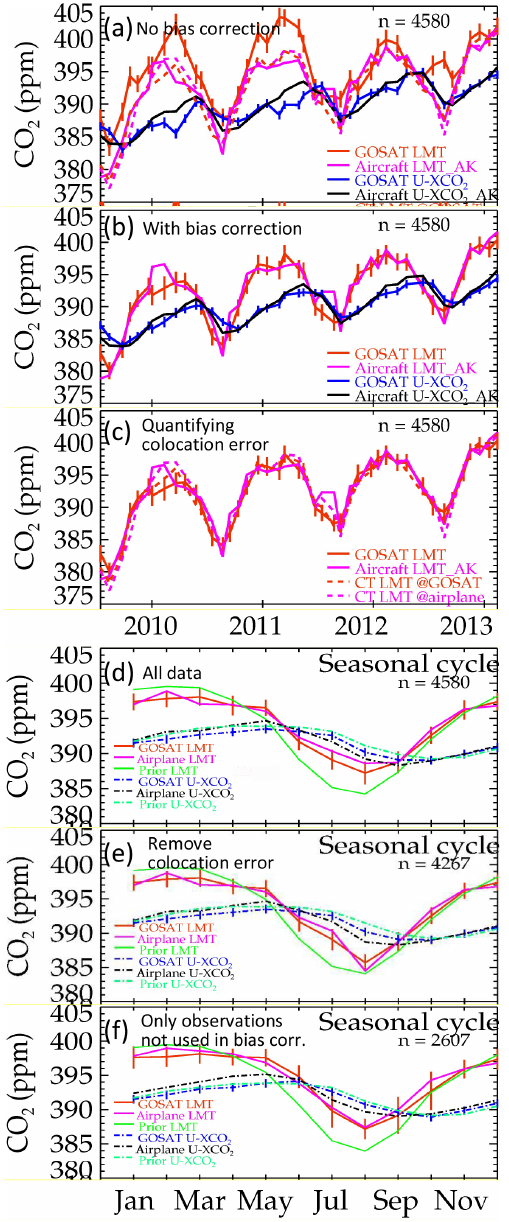
Figure 5. GOSAT versus aircraft data at the SGP site (37 ◦ N, 95 ◦ W). (a, b, c) Aircraft LMT (pink) and U (blue) versus GOSAT LMT (red) and U (black) for monthly averages of GOSAT and air- plane matches. (a) Using no bias correction, (b) using bias cor- rection factors derived in Appendix A. (c) Also showing Car- bonTracker matched to GOSAT (red dotted) and CarbonTracker matched to aircraft (pink dotted) for LMT. (d) Seasonal cycle of GOSAT and airplane, same colors as top panels, and adding the priors in green. (e) Seasonal cycle, but removing months where the CarbonTracker differences seen in (b) are larger than 2.5ppm. (f) Same as (e) but with observations used in the bias correction removed from the